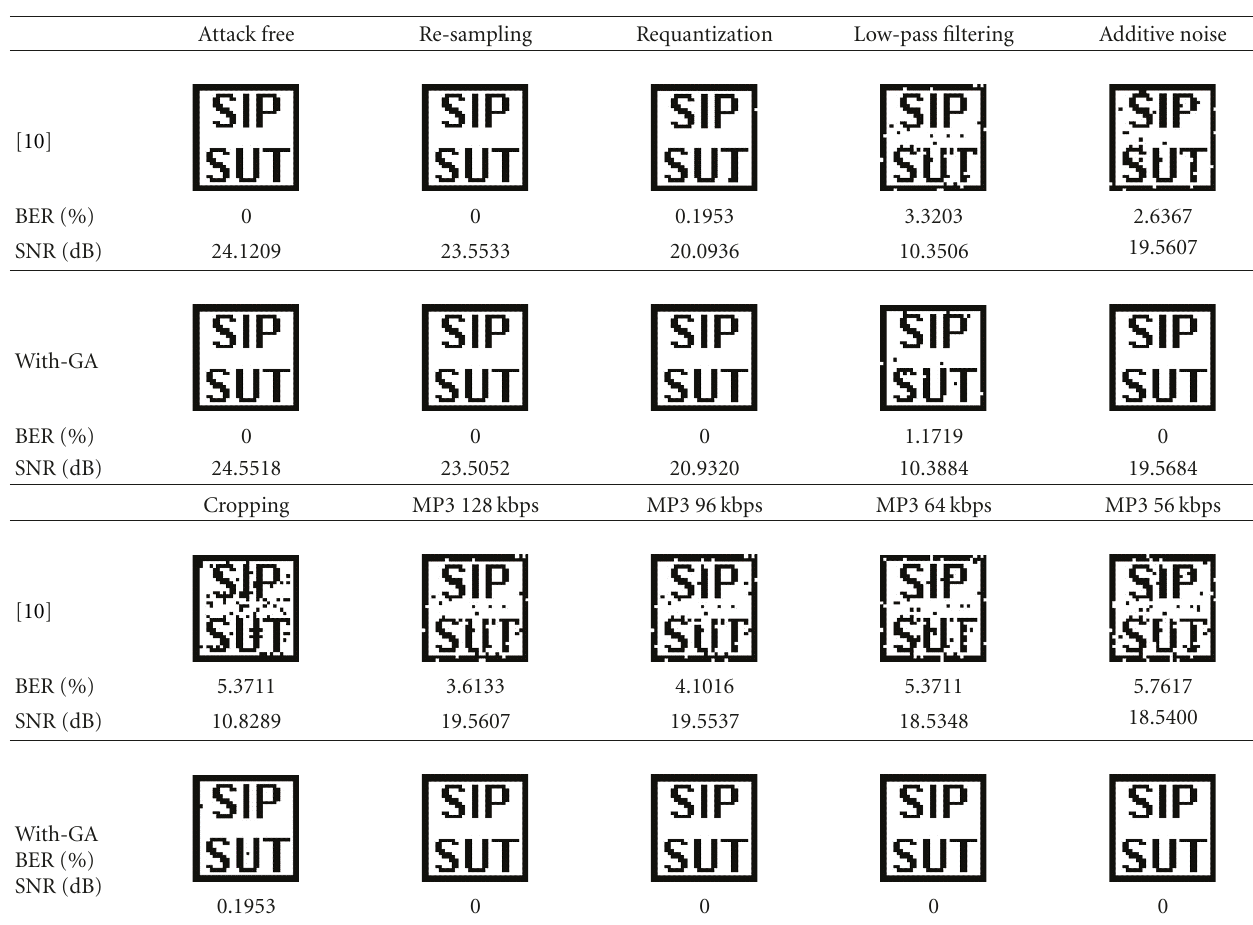
Table 7: Algorithm